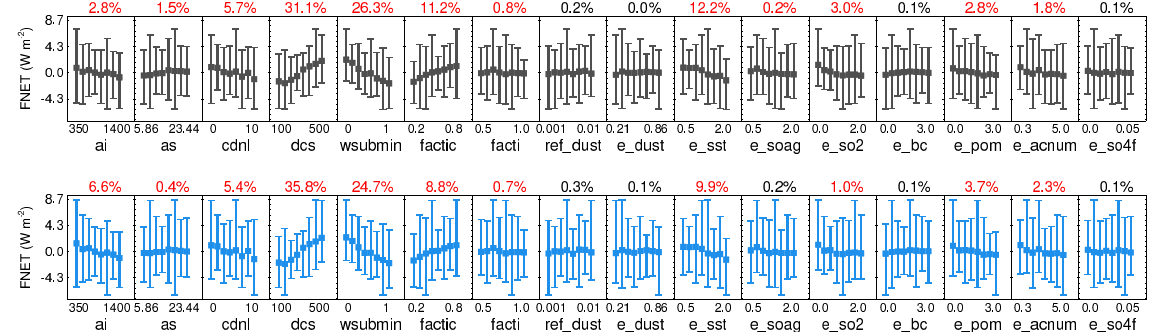
Figure 10. Sensitivities of the global mean top-of-atmosphere net radiative flux (FNET, unit: W m − 2 ) to the empirical parameters listed in Table 2. CAM5 simulations were carried out using 256 different model configurations corresponding to 256 sampling points drawn from the 16-dimensional parameter space (cf. Table 2 and Sect. 4.1). In each panel, the global mean FNET corresponding to the 256 model configurations are sorted into eight bins according to the values of one perturbed parameter. The spread (minimum to maximum) of FNET within a bin is shown by a vertical bar, while the mean value is indicated by a square mark. Note that the FNET shown here is the anomaly relative to the mean of the 256 simulations/ensembles. The mean values that have been subtracted are given in Table 3. Numbers noted above the panels are the relative contribution of individual parameters to the total variation of FNET, estimated using a generalized linear model (cf. Sect. 4.4). Red font means the contribution is statistically significant at the 95% confidence level. The upper row shows results obtained from the AMIP simulations of Zhao et al. (2013) (cf. Sect 4.1). The lower row shows results from the ensemble simulations performed in this study.